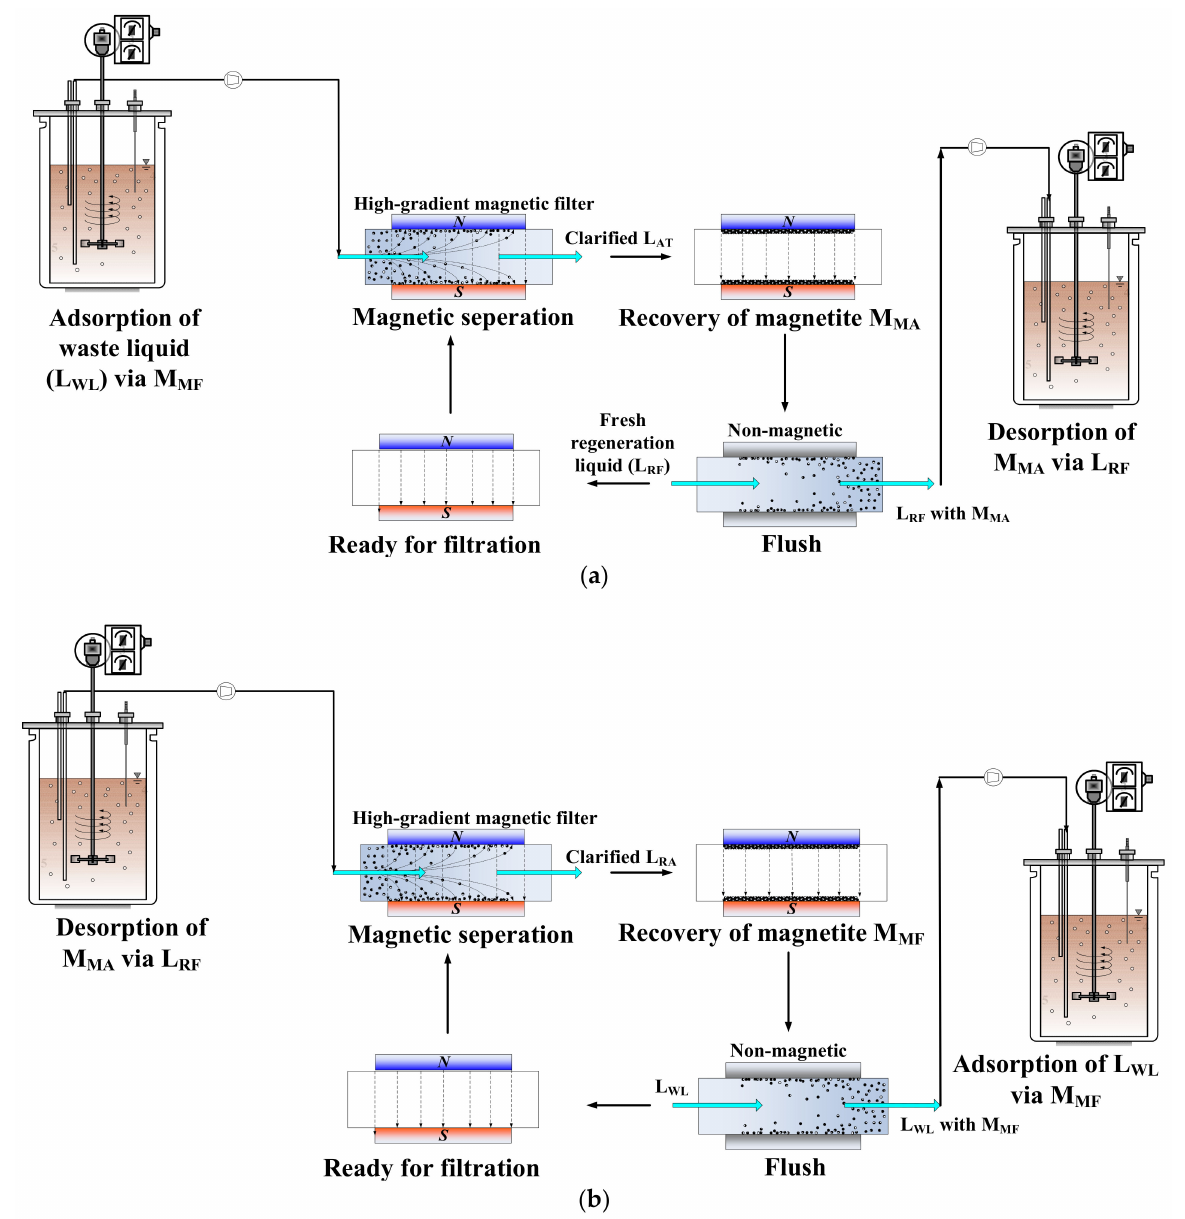
Figure 1. Application of high-gradient magnetic separation (HGMS) incorporated with adsorption and desorption operations. ( a ) Adsorption of waste liquid ( L WL ) via fresh or freshed (regenerated) magnetite ( M MF ) and recovery of aged magnetite ( M MA ); L AT : adsorption treated liquid. ( b ) Desorp- tion/regeneration of M MA via fresh regeneration liquid ( L RF ) and recovery of freshed (regenerated) magnetite M MF ; L RA : aged regeneration liquid. A filter chamber with size 2.75 × 1.75 × 7.85 cm 3 (volume of filter chamber or cell volume V c = 37.78 cm 3 , height of filter chamber L = 7.85 cm, cell cross-section area A c = 4.8125 cm 2 ), containing magnetic matrices, is placed vertically between the poles of the magnet. The matrices are surrounded by a sheet metal housing forming chambers for flow distribution. The matrix filling factor F with all received matrices of mass m wm of 34.5466 g filled in the chamber is 0.1157. The supply and discharge connectors are placed at the ends of the flow distribution chambers. The density of the magnetic wire of the matrix ρ wm is 7900 kg m − 3